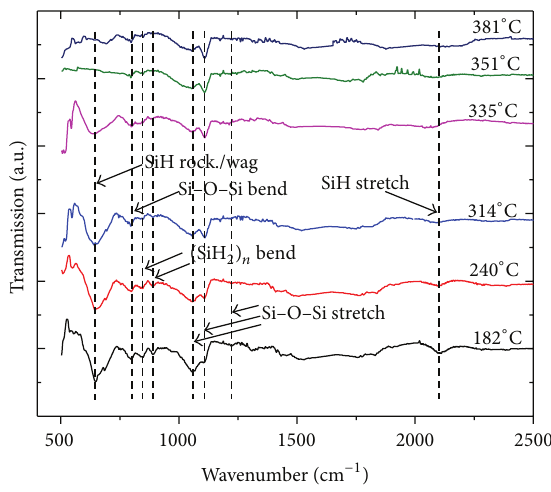
Figure 7: Effective lifetime as a function of process temperature. A relatively large process window is observed, which makes the a- SiO 𝑥 :H films less sensitive to deposition temperature. The line is a guide to the eye. The inset shows the sample structure for lifetime extraction.